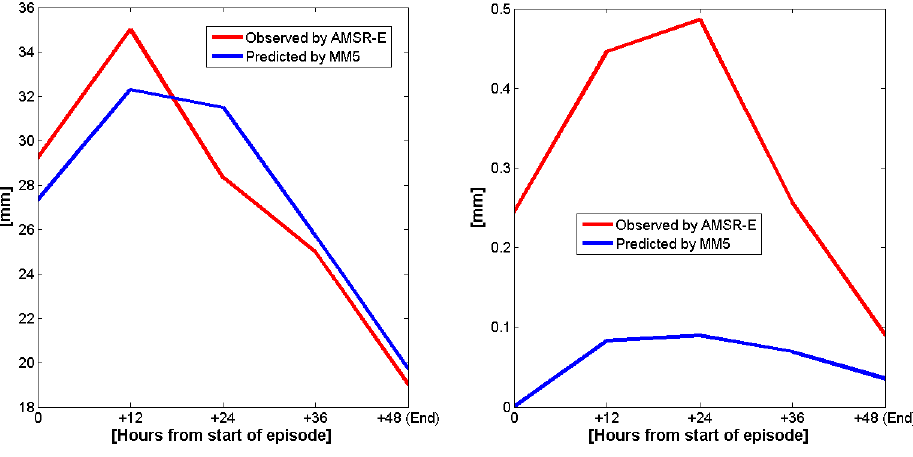
Fig. 13. Evolution of observed and predicted average values over the sea for columnar water vapor (left) and columnar cloud liquid water (right) during the episode. 4